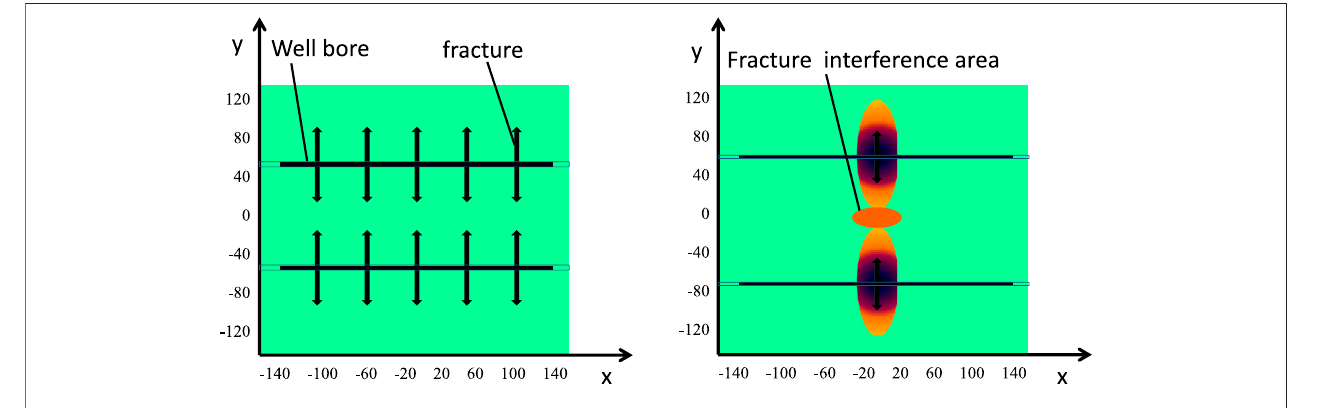
FIGURE 5 | Schematic diagram of synchronous fracture tip interference in horizontal well.